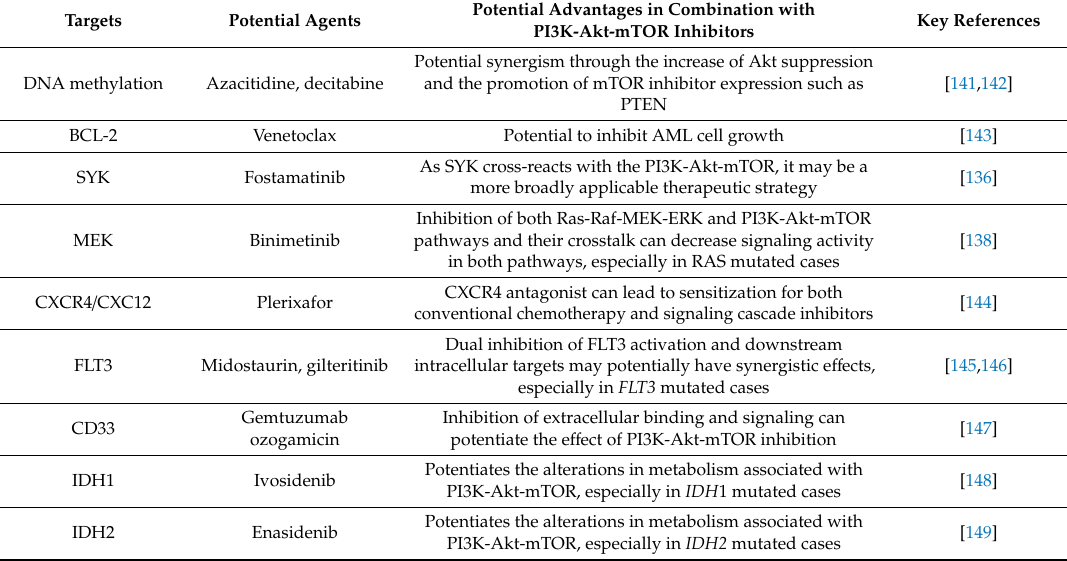
Table 2. Emerging therapeutic interventions in AML and their potential benefits in combination with PI3K-Akt-mTOR inhibitors. The table summarizes new drugs in AML therapy, and shortly describes the potential benefits of combining them with PI3K-Akt-mTOR inhibitors. Key references for the new agents and their use in AML are given in the